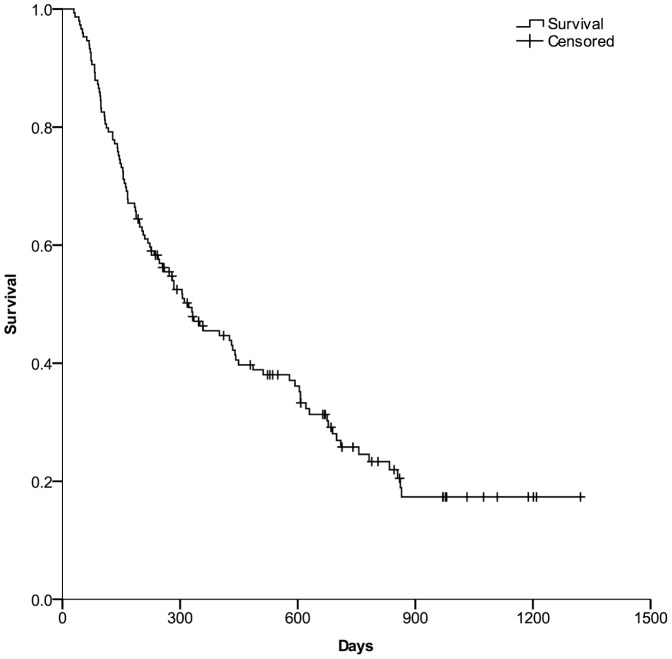
The overall survival in the whole series.Kaplan–Meier curves were generated to show the overall survival of the whole HCC patients after SIRT.